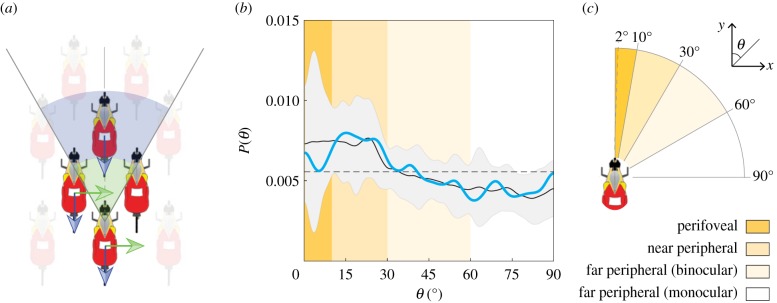
Information propagation and network structure are governed by the visual sensory system. (a) In the underlying diamond structure, the cyclist at the back reacts to transverse motions of nearest neighbours (green arrows), but reacts to longitudinal motions of the cyclist at the front of the diamond, two neighbours away (blue arrows). (b) Neighbouring cyclists have higher probability P(θ) of being oriented within θ ∈ [0, 30°]. The solid black curve is the mean probability from six different cases (electronic supplementary material, figure S2); light grey bands are 95% uncertainty bounds; light blue curve corresponds to figure 5e; horizontal dashed line is average P(θ) over all θ. (c) The range of the near-peripheral visual field corresponds to the most frequently occurring angles in the cyclist network (adapted from [39,43]; central 2° arc is foveal vision). (Online version in colour.)